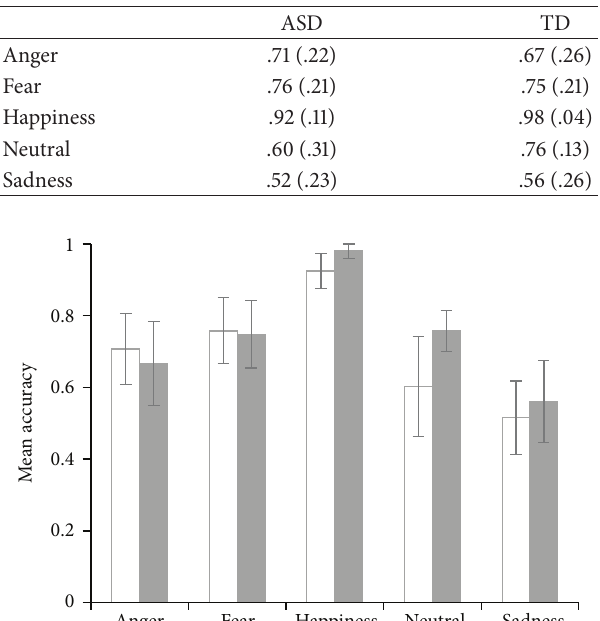
Table 2: Accurate labeling of the expressions for both participant groups: mean accuracy and standard deviation (between brackets).